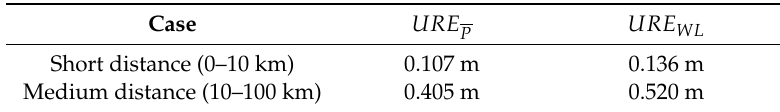
Table 5. URE of CSC and WL measurements.